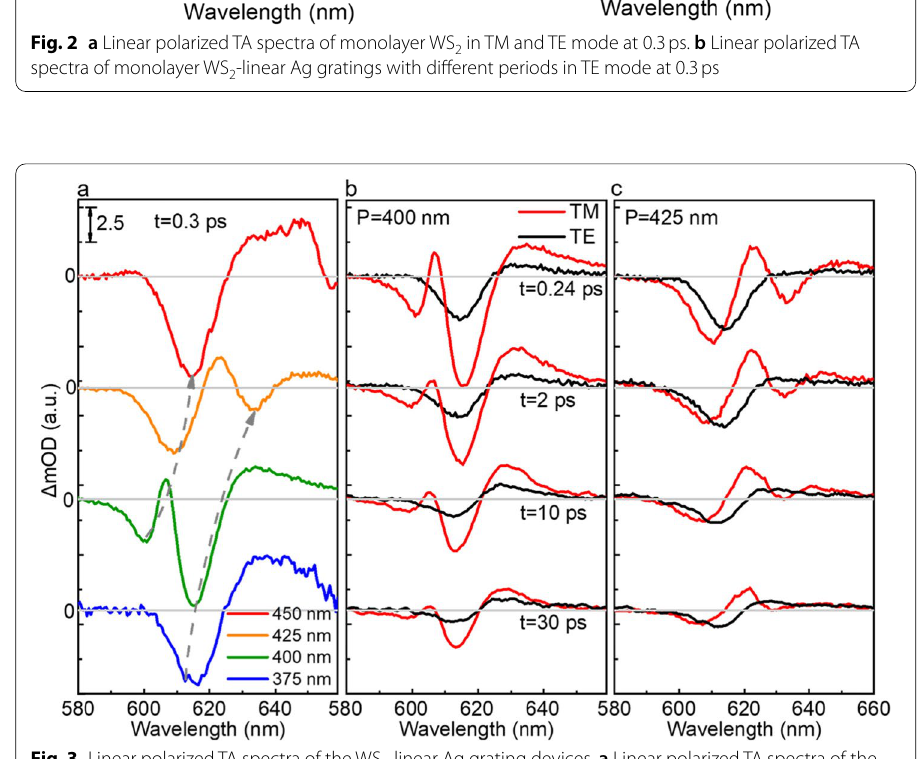
Fig. 3 Linear polarized TA spectra of the WS 2 ‑linear Ag grating devices. a Linear polarized TA spectra of the WS 2 ‑linear Ag grating devices probe in TM mode with different periods. b , c Evolution of linear polarized TA spectra at different delay times (0.24 ps, 2 ps, 10 ps, 30 ps) probed in TE (black line) and TM (red line) mode with a period of 400 nm ( b ) and 425 nm ( c ). The excitation wavelength is 560